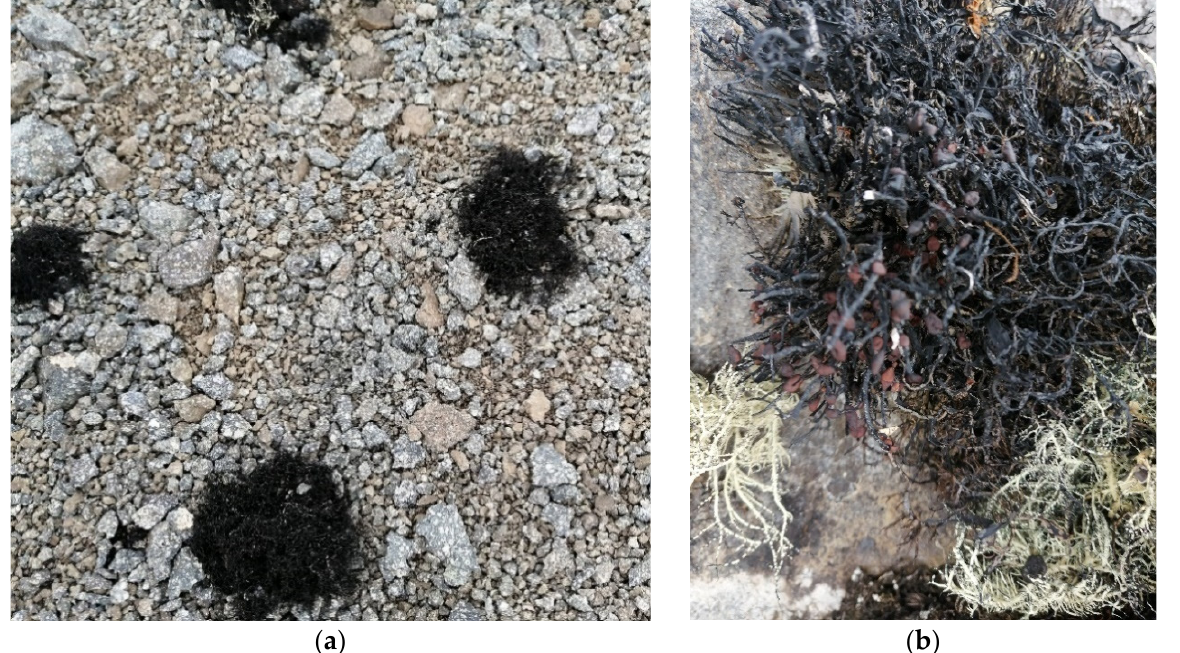
Figure 1. ( a ) H. lugubris growing on King George Island collected in February 2021. ( b ) Close picture.